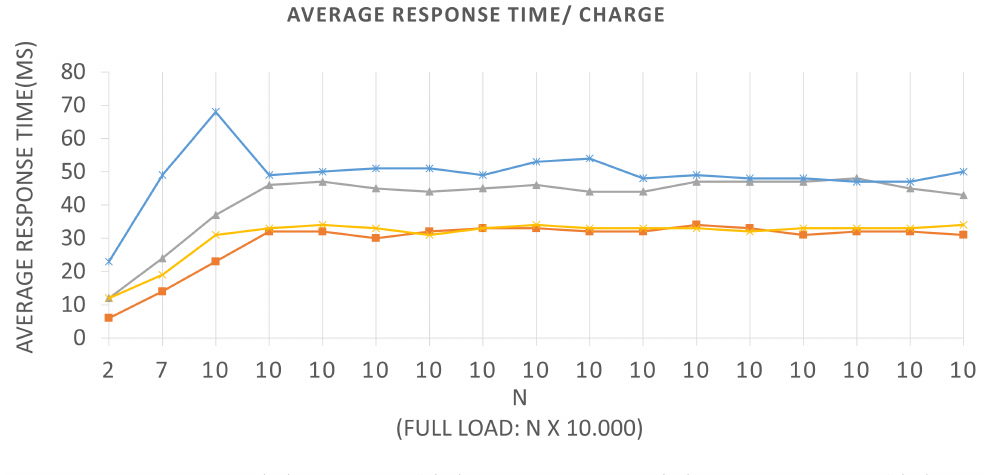
Figure 8. Results of the experiments for insertion